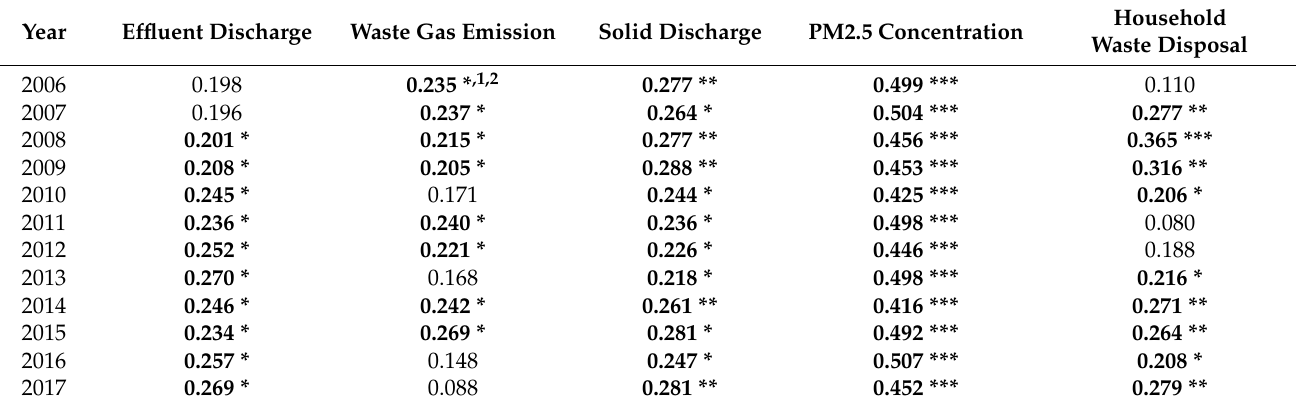
Table 4. Global Moran’s I based on Matrix